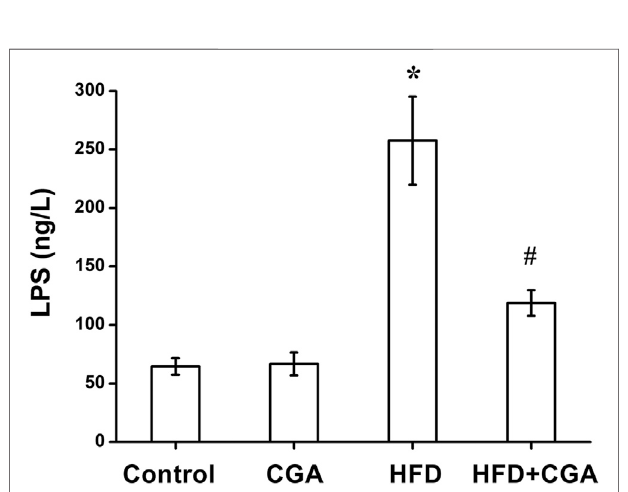
FIGURE 6 | Effect of CGA on the level of GLP-1 in portal vein. Data are presented as mean ± SD. * p < 0.05 as compared with the control group; # p < 0.05 as compared with the HFD